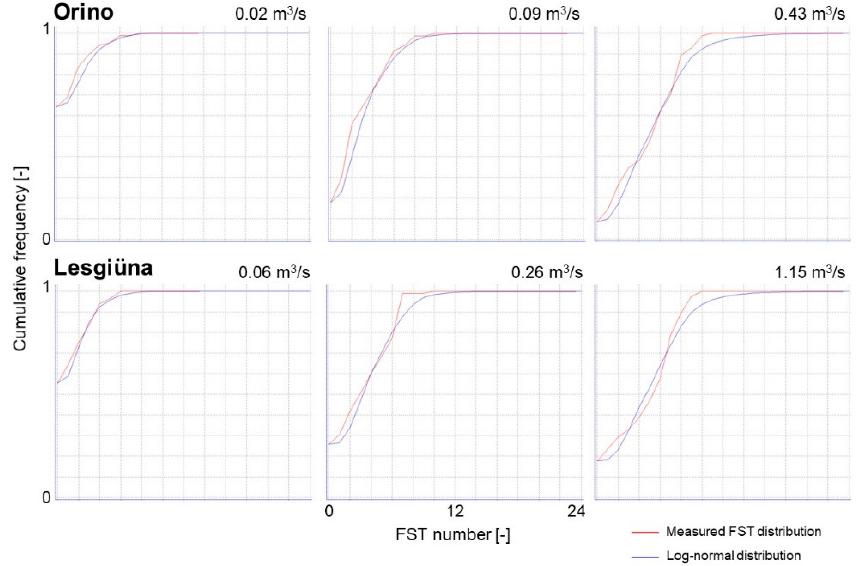
Figure A2. CASiMiR hydraulic model fit to observed values of FST numbers at the measured discharges in the Orino and the Lesgiüna.